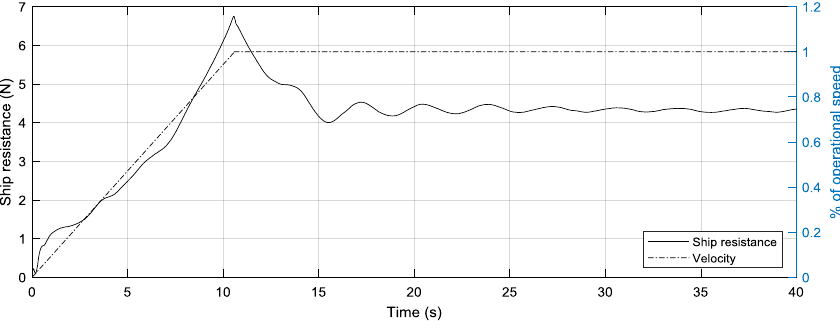
Figure 6. Example time-history of the solution (depicted: 𝐹 ℎ = 0.57).